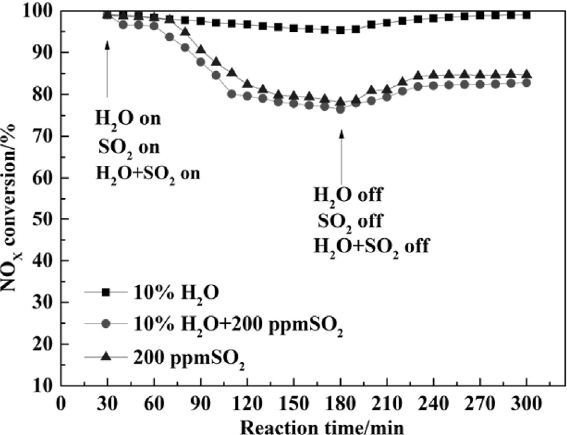
Figure 26. SO 2 + H 2 O tolerance test at 240 °C (Reaction conditions: [NH 3 ] = [NO] = 550 ppm, [O 2 ] = 5 vol %, [SO 2 ] = 100 ppm, [H 2 O] = 10 vol % (when used), N 2 as balance gas, GHSV=20,000 h − 1 ). (Reproduced with permission from Reference [49], Copyright 2016, The Royal Society of Chemistry.).